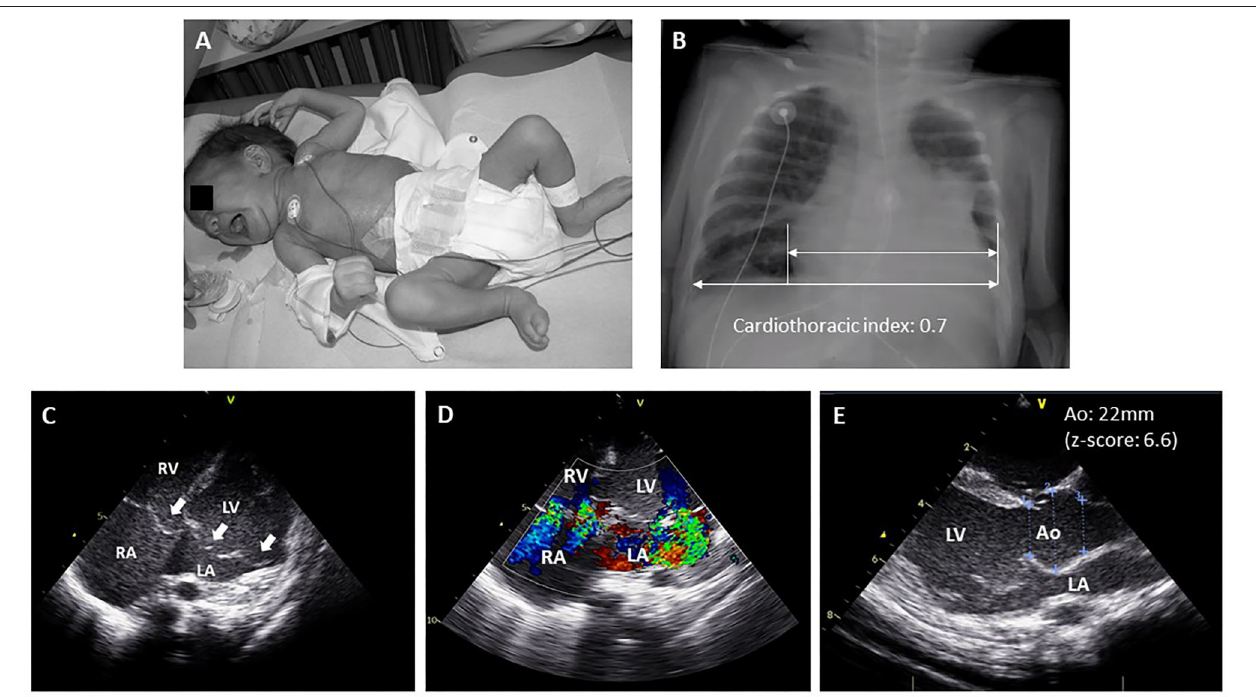
FIGURE 1 | Typical manifestations of neonatal Marfan syndrome. (A) Child with neonatal MFS showing arachnodactyly, long feet, crumpled ears, lipodystrophy and mild pectus excavatum. (B) Chest X-ray showing cardiomegaly and mild scoliosis. (C) Echocardiographic four-chamber view showing mitral and tricuspid valve prolapse (white arrows). (D) Echocardiographic apical four-chamber color doppler view showing moderate-severe mitral and tricuspid valve regurgitation. (E) Echocardiographic parasternal long axis view showing enlargement of the sinus of Valsalva. Ao, aorta; LA, left atrium; LV, left ventricle; RV, right ventricle; RA, right